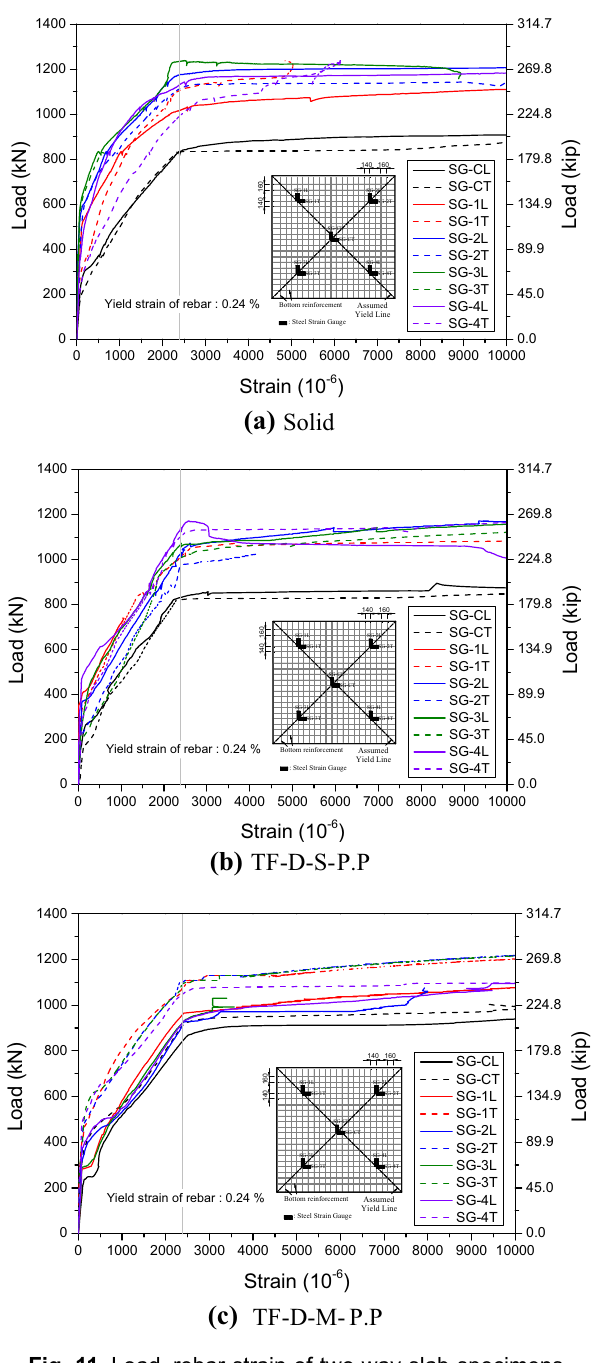
Fig. 11 Load–rebar strain of two-way slab